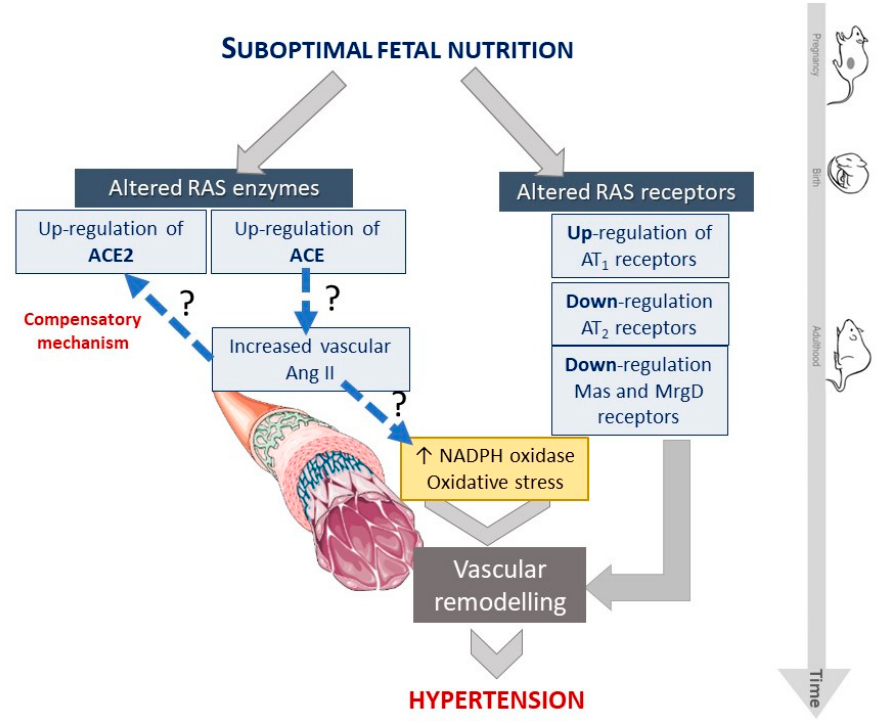
Figure 7. Scheme representing the impact of RAS and NADPH oxidase alterations induced by fetal undernutrition that led to vascular remodeling/fibrosis and hypertension.